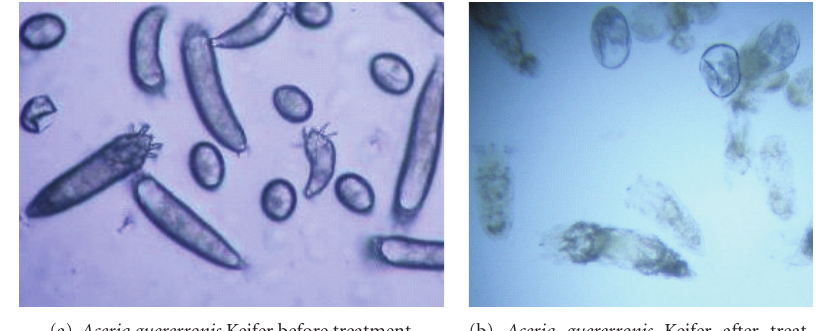
Figure 2: Eriophyid mite before and after botanical biocide